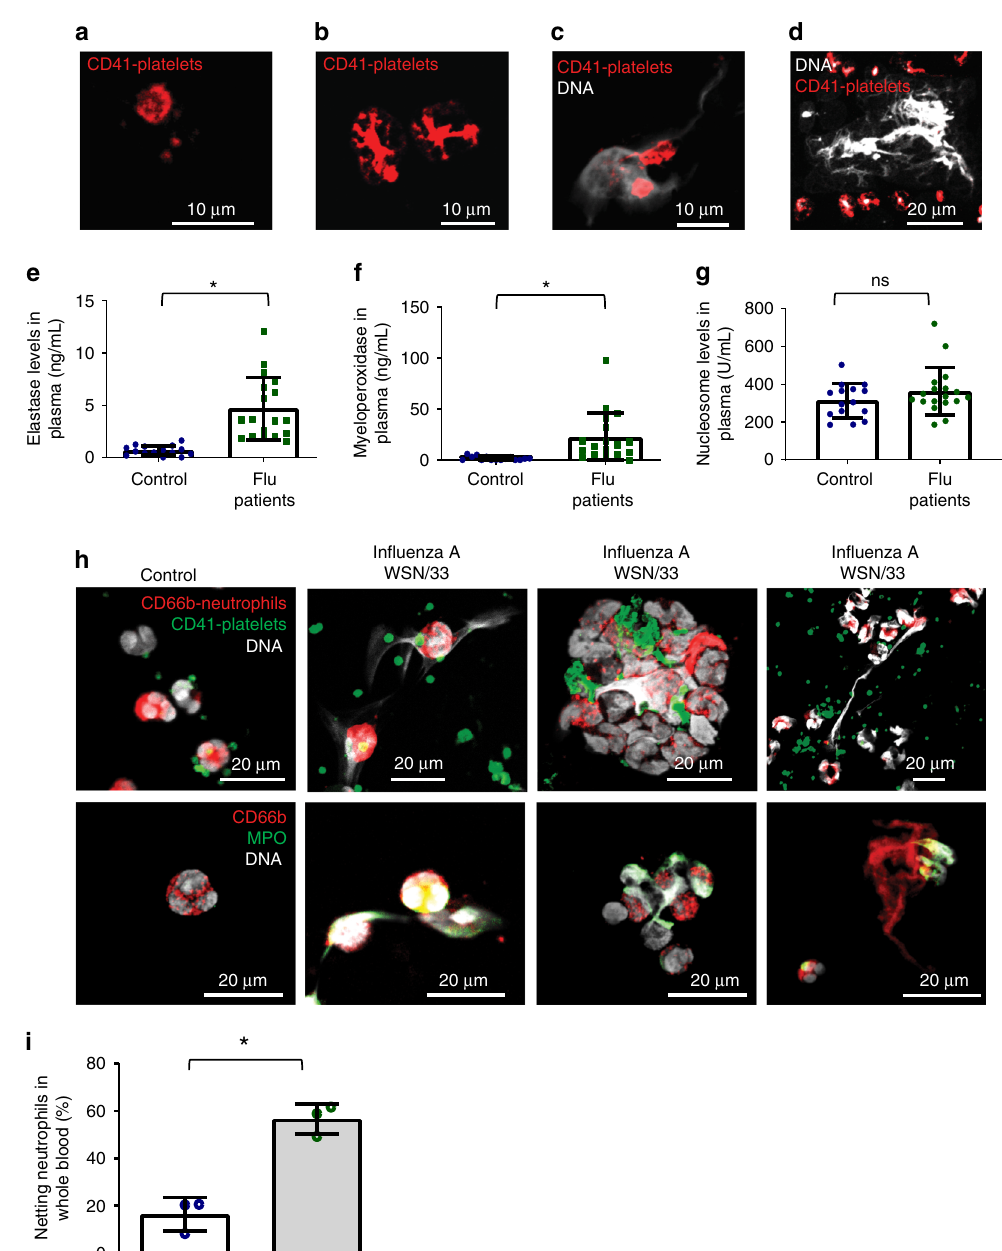
Fig. 1 Characterization of human blood from in fl uenza-infected patients. a – d Blood from in fl uenza-infected patients was fi xed after intravenous collection and stained as described in Methods. In all cases DNA was assessed by DAPI. a Many platelets appeared similar to those observed in control blood from healthy donors with a size of 2 – 5 µ m. b Some platelets from in fl uenza-infected patients had undergone spreading with a distinctive distribution of CD41. c Platelets and platelet microparticles associated with DNA (arrow). d Spread platelets were found surrounding released DNA with distinct DNA content in their center. Of note, blood from in fl uenza-infected patients and controls in ( a – d ) was not permeabilized. Since formaldehyde can cause certain levels of permeabilization as a function of cross-linking positive staining in control samples for H4 and MPO do not necessarily indicate activation. e – g Levels of proteins related to DNA release in the plasma of in fl uenza-infected patients assessed by ELISA. Source data are provided as a Source Data fi le. e neutrophil elastase, f myeloperoxidase (MPO), and g histone nucleosome core. The graphs represent the average ± SD of healthy donors ( n = 15) and in fl uenza- infected patients ( n = 18); signi fi cance for ( e – g ) was assessed by Mann – Whitney U test, star symbol (*) indicates p < 0.0001. h , i To synchronize time of in fl uenza presence as a function of infection and quantify the released DNA, we treated blood from human donors for 30 min with sucrose-puri fi ed infectious in fl uenza (WSN/33) at constant rotation and 37 °C. In fl uenza was used at 1 pfu to 100 platelets. h Representative images of blood from 3 donors with in fl uenza and one (out of 3) healthy control and i their quantitation. Of note, in certain cases the DNA is not entirely covered with platelets, suggesting differences in kinetics of interaction and/or a physiological relationship that needs further in vivo characterization. Data in graph is represented as average ± SD of n = 3 different donors; signi fi cance was assessed by unpaired t -test (two-tailed value) and star symbol (*) indicates p = 0.0019, df =